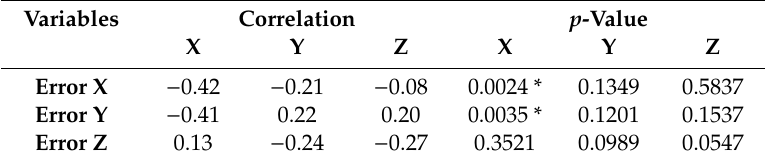
Table 3. Correlation matrix and p -value referring to the error values with 50 GCP dataset.